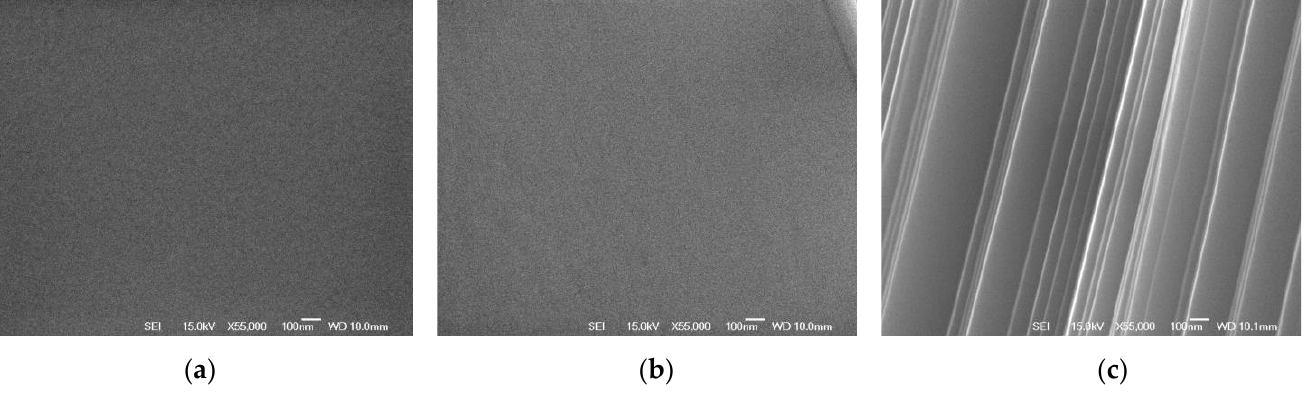
Figure 3. Scanning electron microscope micrographs showing cleaved surfaces of ( a ) as-grown pris- tine, ( b ) Co-intercalated and ( c ) Co-doped InSe crystals.